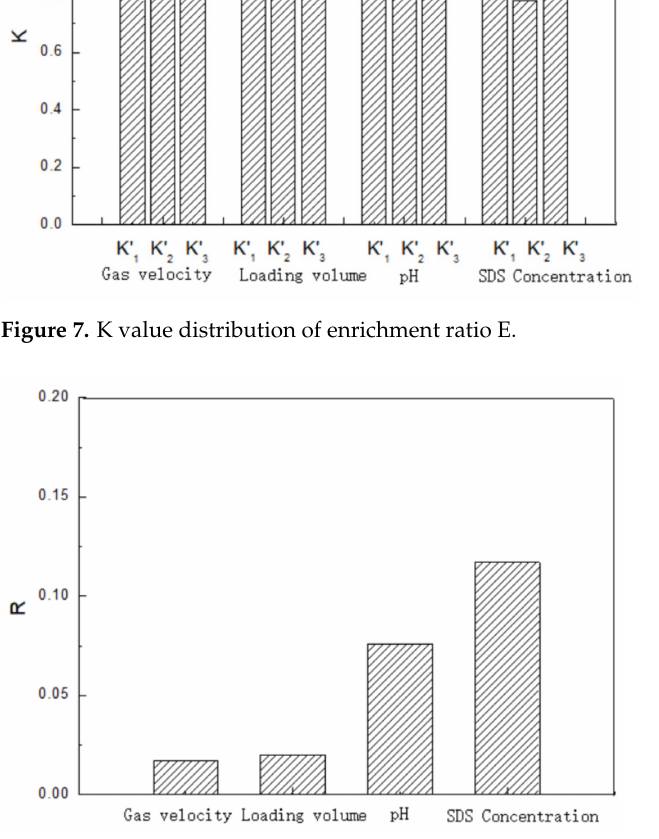
Figure 8. R value distribution of enrichment ratio E.